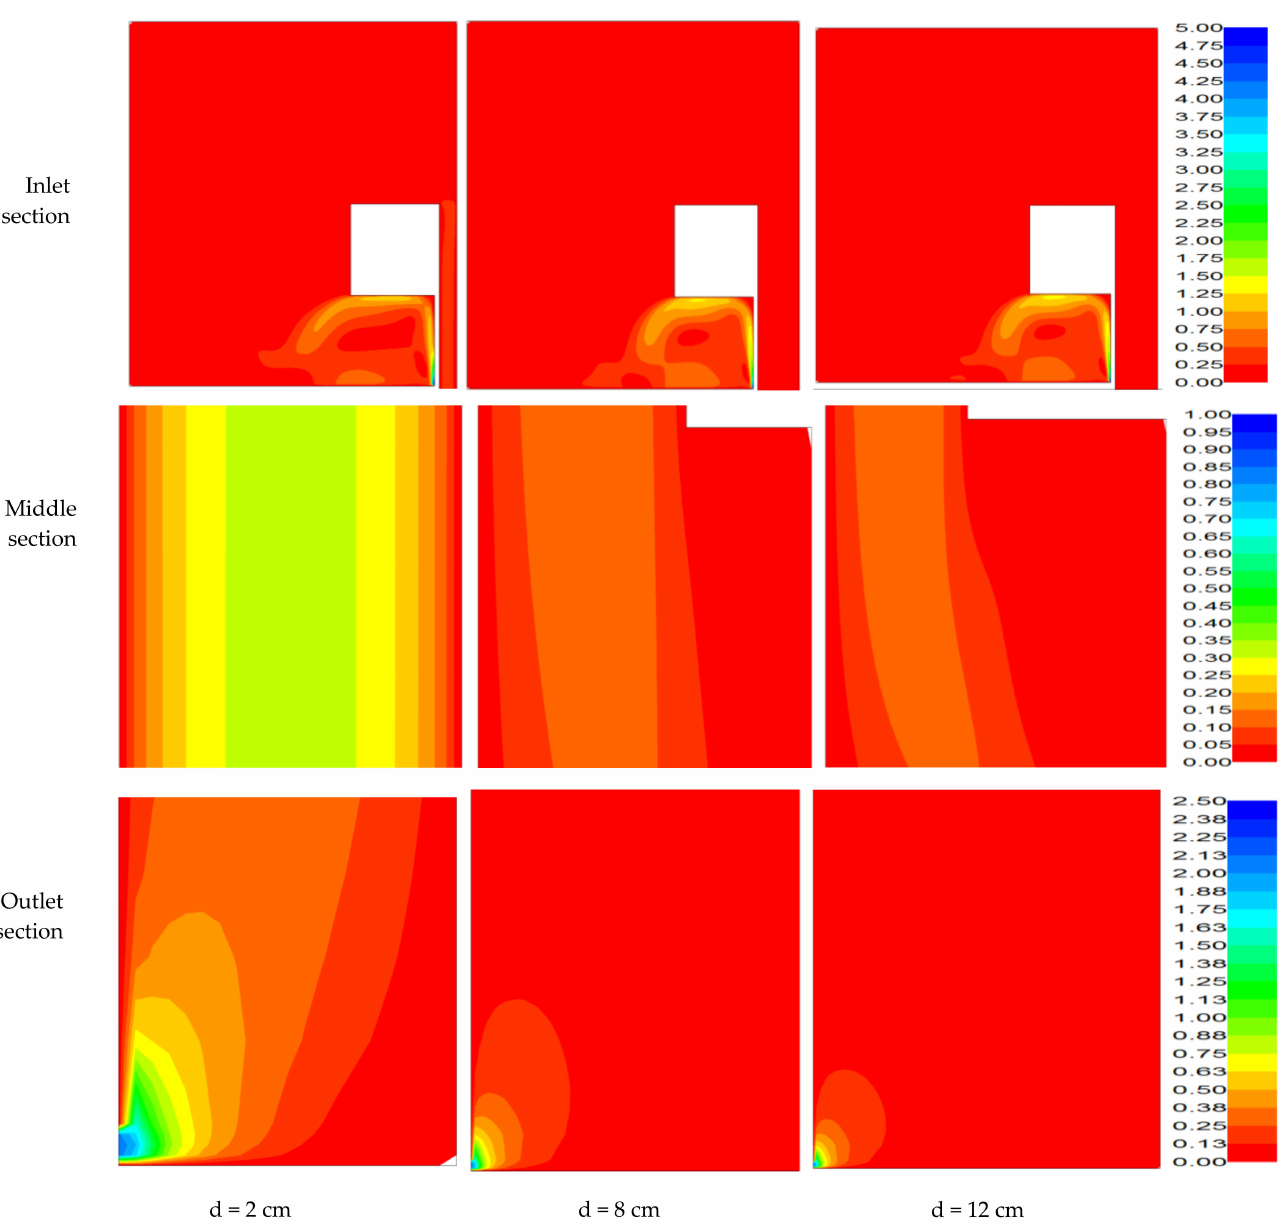
Figure 10. The change of wind velocity cloud in the cavity with air layer